Question: What visual encoding does this figure use to show its data?
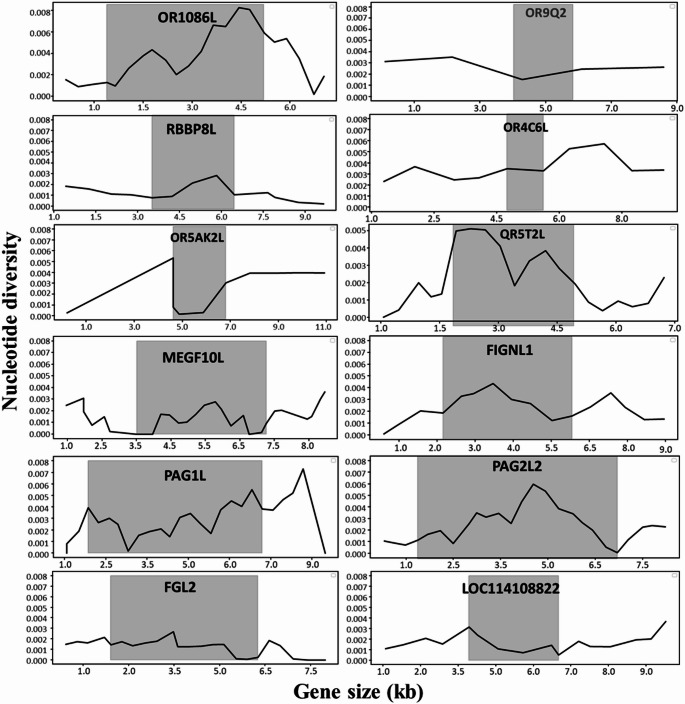
Answer: line